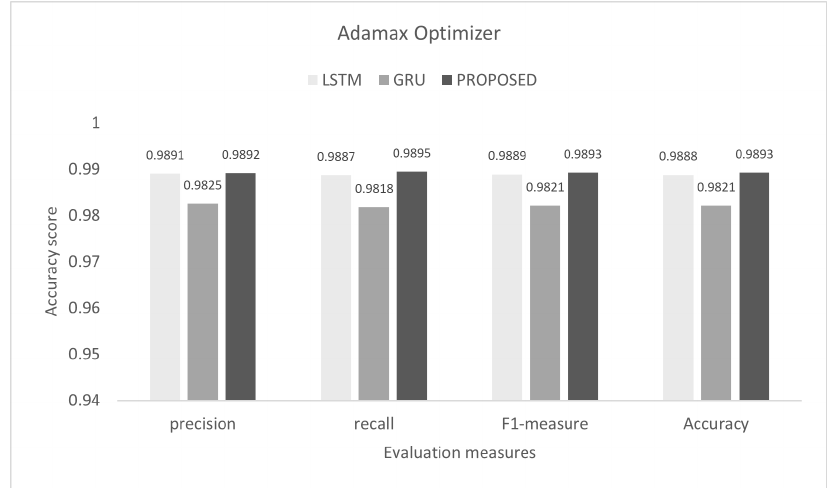
Figure 9. Evaluation on Adamax with the combined DDoS